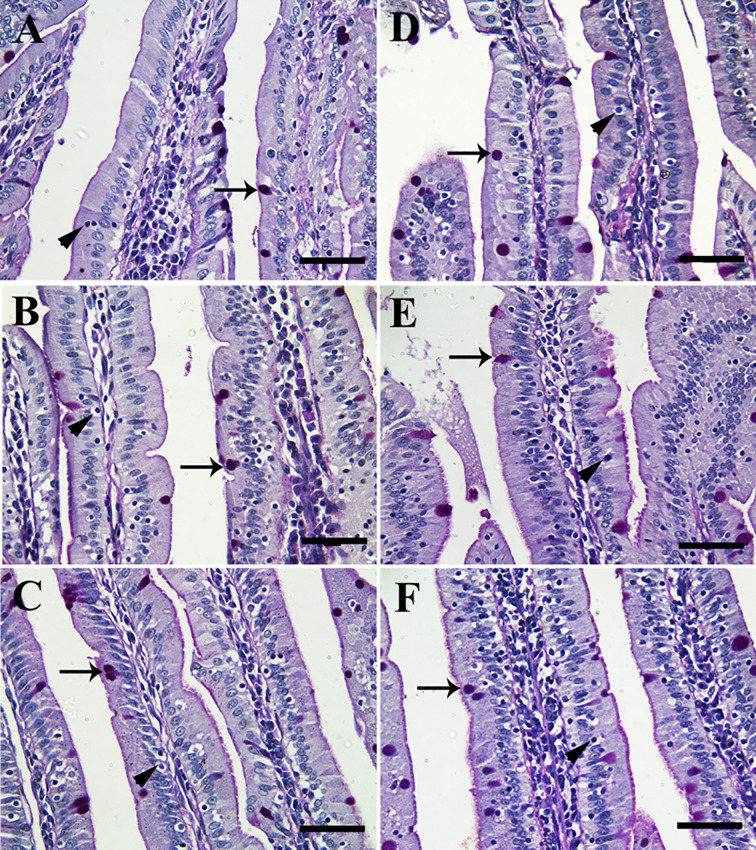
Light micrographs of duodenum showing the effect of different doses of β glucan; control, 0.25 g β glucan (βG0.25), 0.5 g β glucan (βG0.5) on the two rabbit species; New Zealand White (NZW) and APRI rabbits were represented in (A to C) and from (D to F), respectively. The micrographs revealing the different epithelial lymphocytic infiltration from (A to C) and from (D to F). Lymphocytes (arrowheads) and goblet cells (arrows). PAS stain. Scale bar is 50 μm.